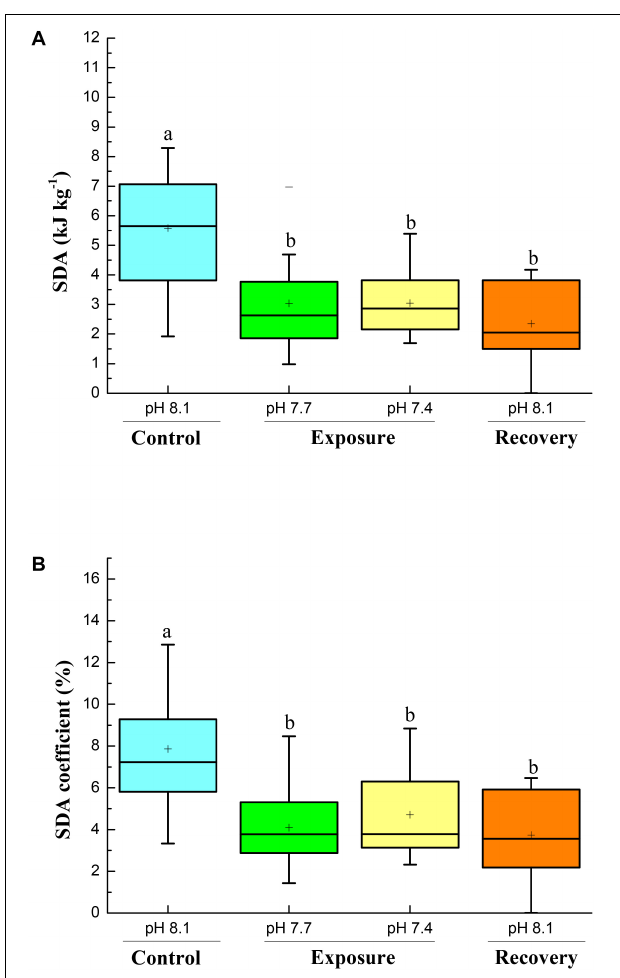
FIGURE 3 | SDA (kJ kg − 1 , A ) and SDA coefficient (B) of C. pagurus at varying pH conditions (pH 8.1 control), pH 7.7, pH 7.4, and pH 8.1 (recovery). Data were analyzed using one-way ANOVA. Significance was reported at the P < 0.05 levels, Different letters denote that the value was significantly different from the control pH